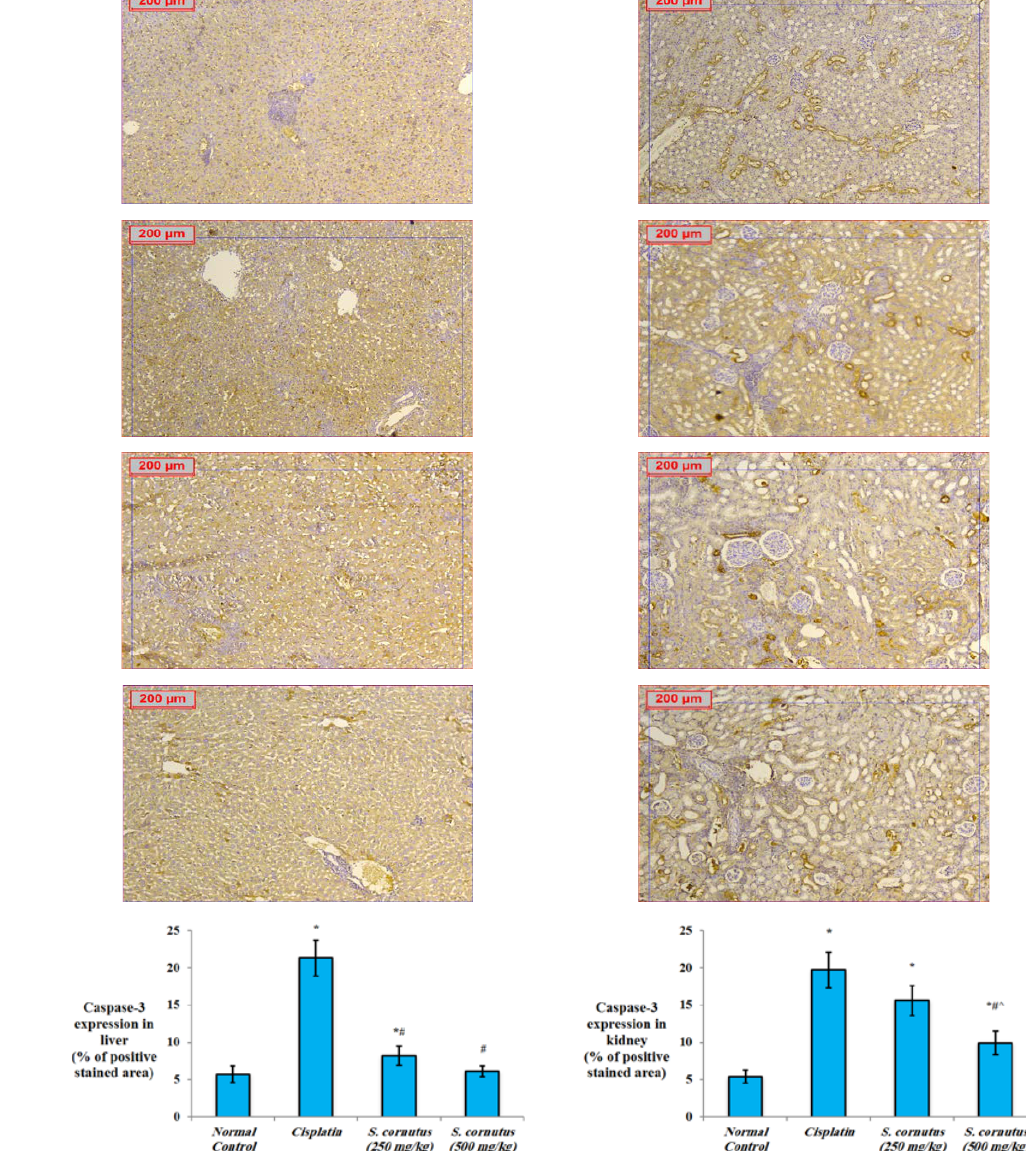
Figure 4. The effect of S. cornutus crude extract on the expression levels of caspase-3 determined by immunohistochemistry in the ( A ) liver and ( B ) kidney tissues of the experimental mice. Data of the percentage of positive stained area are expressed as mean ± SD and analyzed using one-way ANOVA followed by Bonferroni’s post hoc test ( n = 8). * significantly different vs. the normal control group; # significantly different vs. the cisplatin group; ˆ significantly different vs. the S. cornutus (250 mg/kg) group. Differences were considered significant at p <